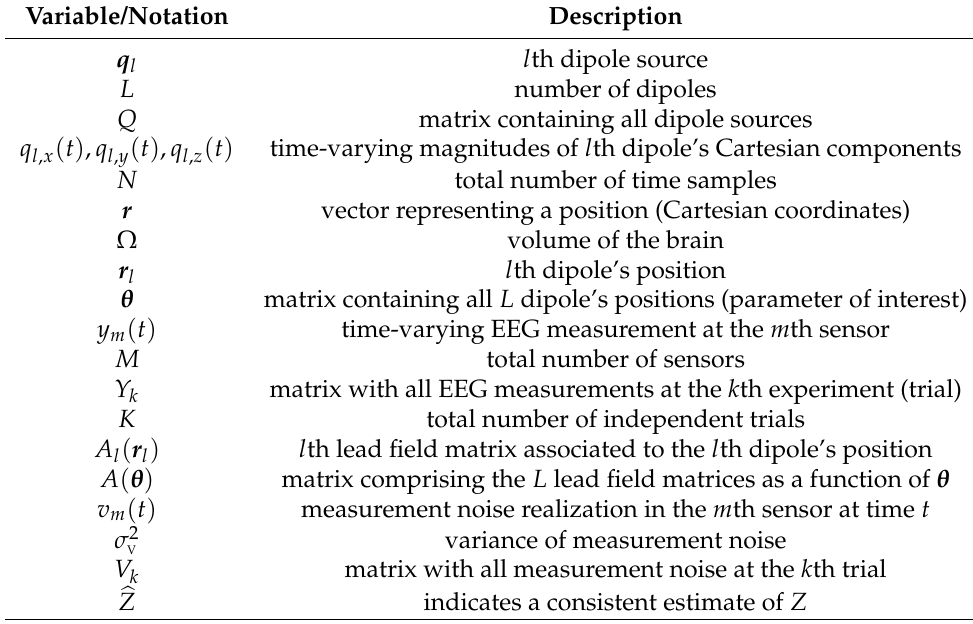
Table 1. Summary of variables and notations used in this paper (arranged in appearance